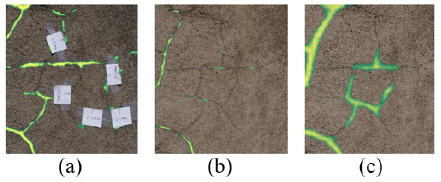
Figure 6. Marked cracks (0.1mm-0.5mm): (a) 1m with the label, (b) 1m without a label, and (c) 3m without a label.